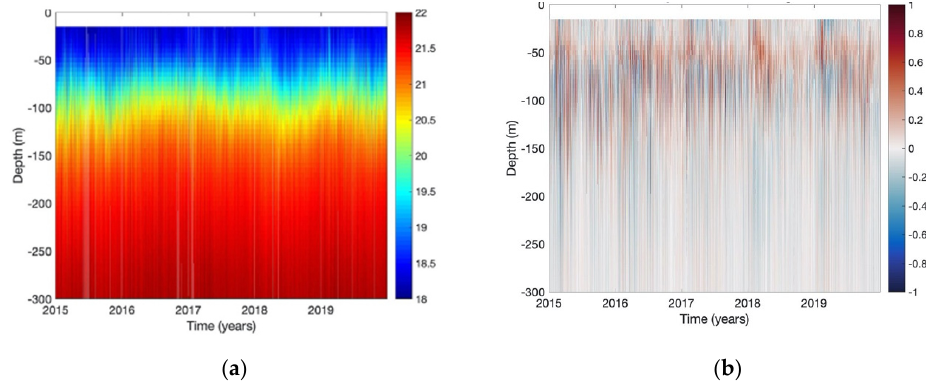
Figure 9. Time versus depth diagram for BSFS salinity (PSU) in the period 2015–2019 ( a ) at the observation location and ( b ) for the computed model minus observation value.